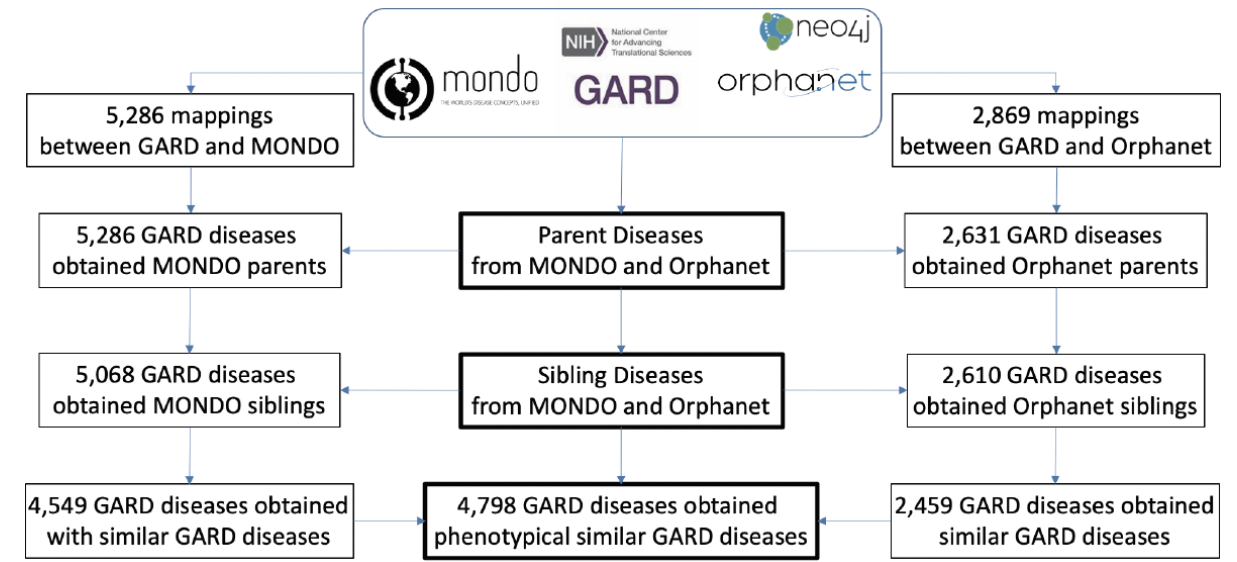
Figure 4. Results of phenotypically similar GARD disease retrieval based on MONDO and Orphanet disease